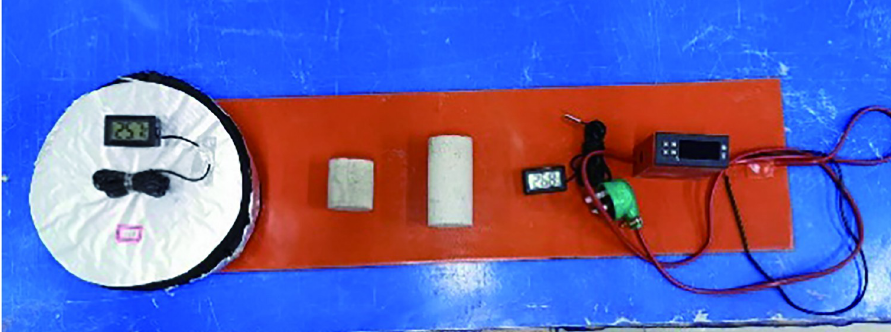
Fig 16. Heating plate used during the